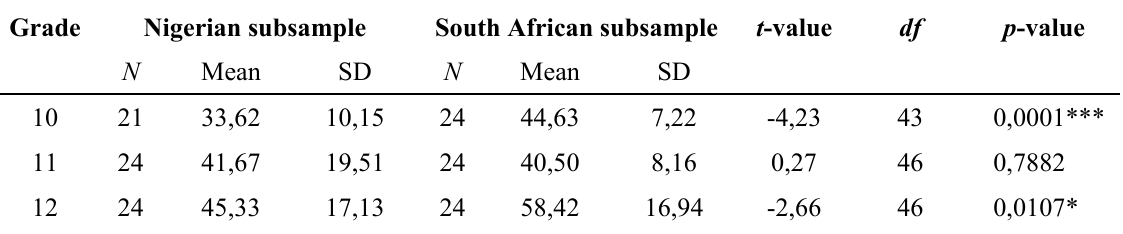
Table 3 : Grade level mean scores in the TPGT